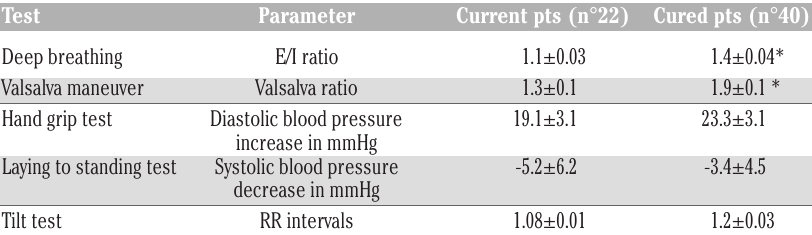
Table 2. Results of autonomic tests in the study groups (Current vs. Cured patients).